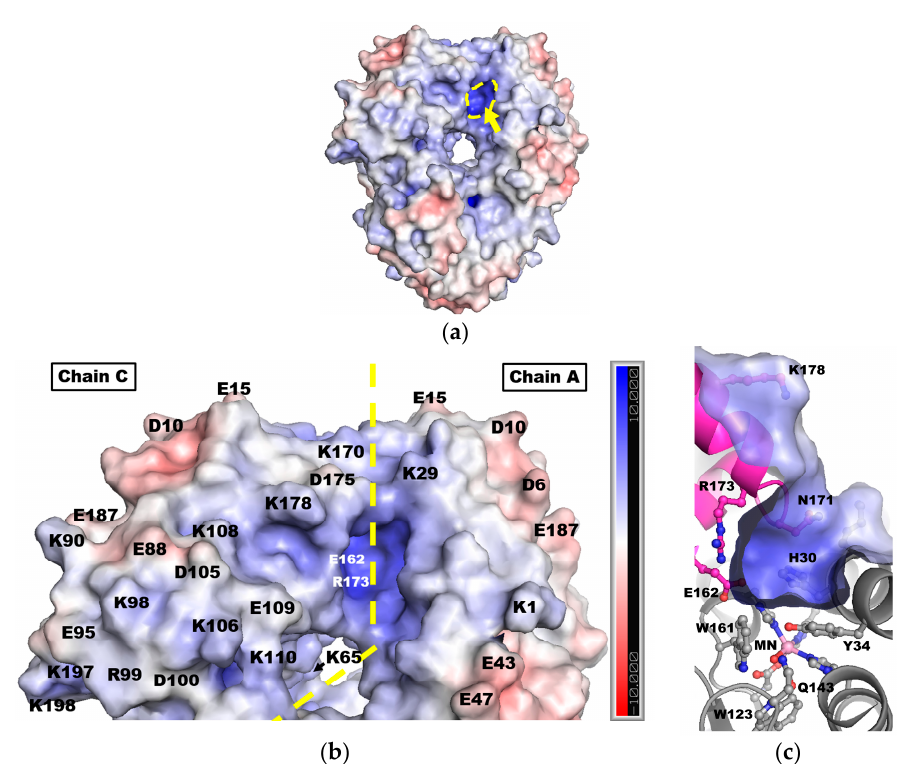
Figure 2. Electrostatic surfaces of human MnSOD. ( a ) The electrostatic surface of the tetramer with only one active site viewed in this orientation (yellow arrow and dashed lines). ( b ) A zoomed-in view of the dimer interface indicated by a yellow, dashed line. The labels for Glu162 and Arg173 are white to indicate their location on the concave surface within the active site pit. ( c ) A cross section-view of the active site across the dimer interface, rotated 90° along the horizontal axis in relation to ( a , b ). Glu162 is behind Arg173 in this view. Electrostatic surface is colored in kiloteslas. Adapted from Azadmanesh et al., 2017 [44]. Single letter amino acid code is used.